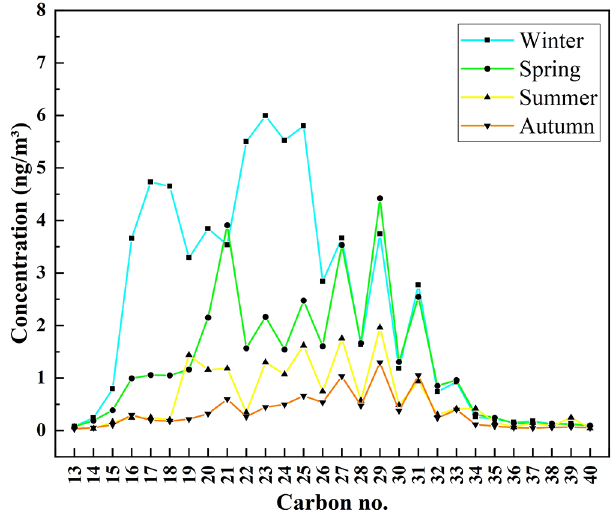
Figure 5. Average concentration distributions of the particulate- bound n -alkane homologs in the different seasons of